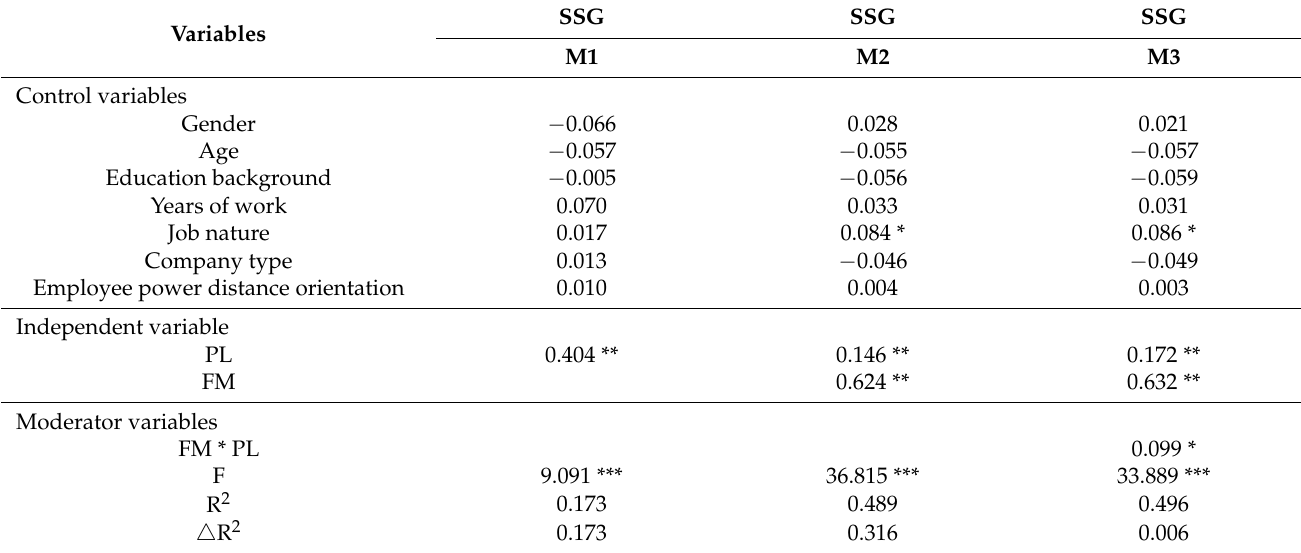
Table 5. Test of moderating effect of